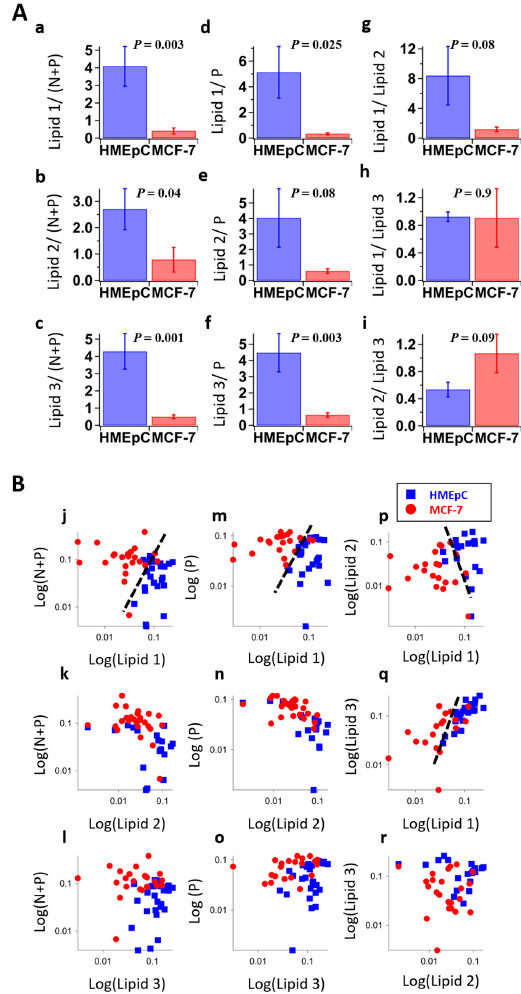
Figure 5. Discrimination analysis by MCR-ALS. ( A ) Relative abundance of MCR-ALS extracted components, ( a ) Lipid 1/ (N + P), ( b ) Lipid 2/ (N + P), ( c ) Lipid 3/ (N + P), ( d ) Lipid 1/P, ( e ) Lipid 2/P, ( f ) Lipid 3/P, ( g ) Lipid 1/Lipid 2, ( h ) Lipid 1/Lipid 3, ( i ) Lipid 2/Lipid 3. N + P: nucleic acid with protein, P: protein. Error bars are standard error of mean. p values obtained by t-test were denoted on top of histograms. ( B ) Scatter plots of each logarithmic abundance, ( j ) Lipid 1 vs. (N + P), ( k ) Lipid 2 vs. (N + P), ( l ) Lipid 3 vs. (N + P), ( m ) Lipid 1 vs. P, ( n ) Lipid 2 vs. P, ( o ) Lipid 3 vs. P, ( p ) Lipid 1 vs. Lipid 2, ( q ) Lipid 1 vs. Lipid 3, ( r ) Lipid 3 vs. Lipid 2. Some labels of measured cells were omitted in those plots since the values of abundance were calculated into zero by MCR-ALS. Broken lines serve as visual guides to separate two groups of